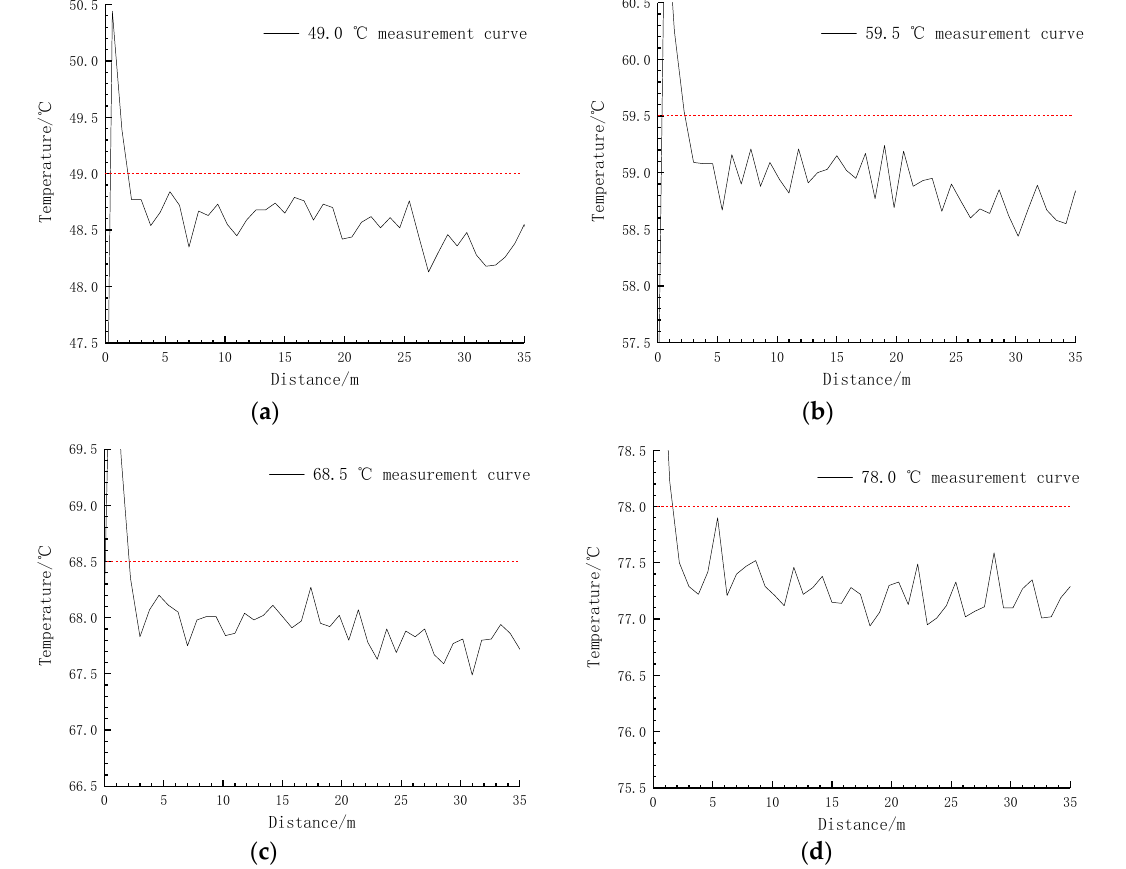
Figure 12. Temperature measurement data: ( a ) 49.0 °C measurement curve; ( b ) 59.5 °C measurement curve; ( c ) 68.5 °C measurement curve and ( d ) 78.0 °C measurement curve.